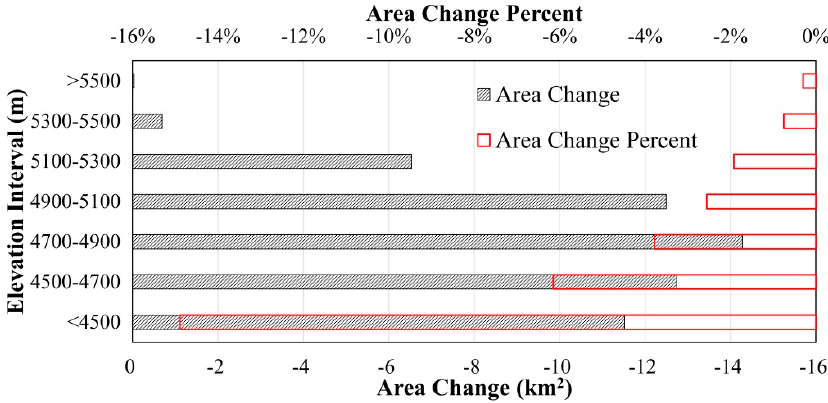
Figure 7. Area changes in glacier hypsometry based on the SCGI and our inventory. All hypsometry was calculated using SRTM (Shuttle Radar Topography Mission).